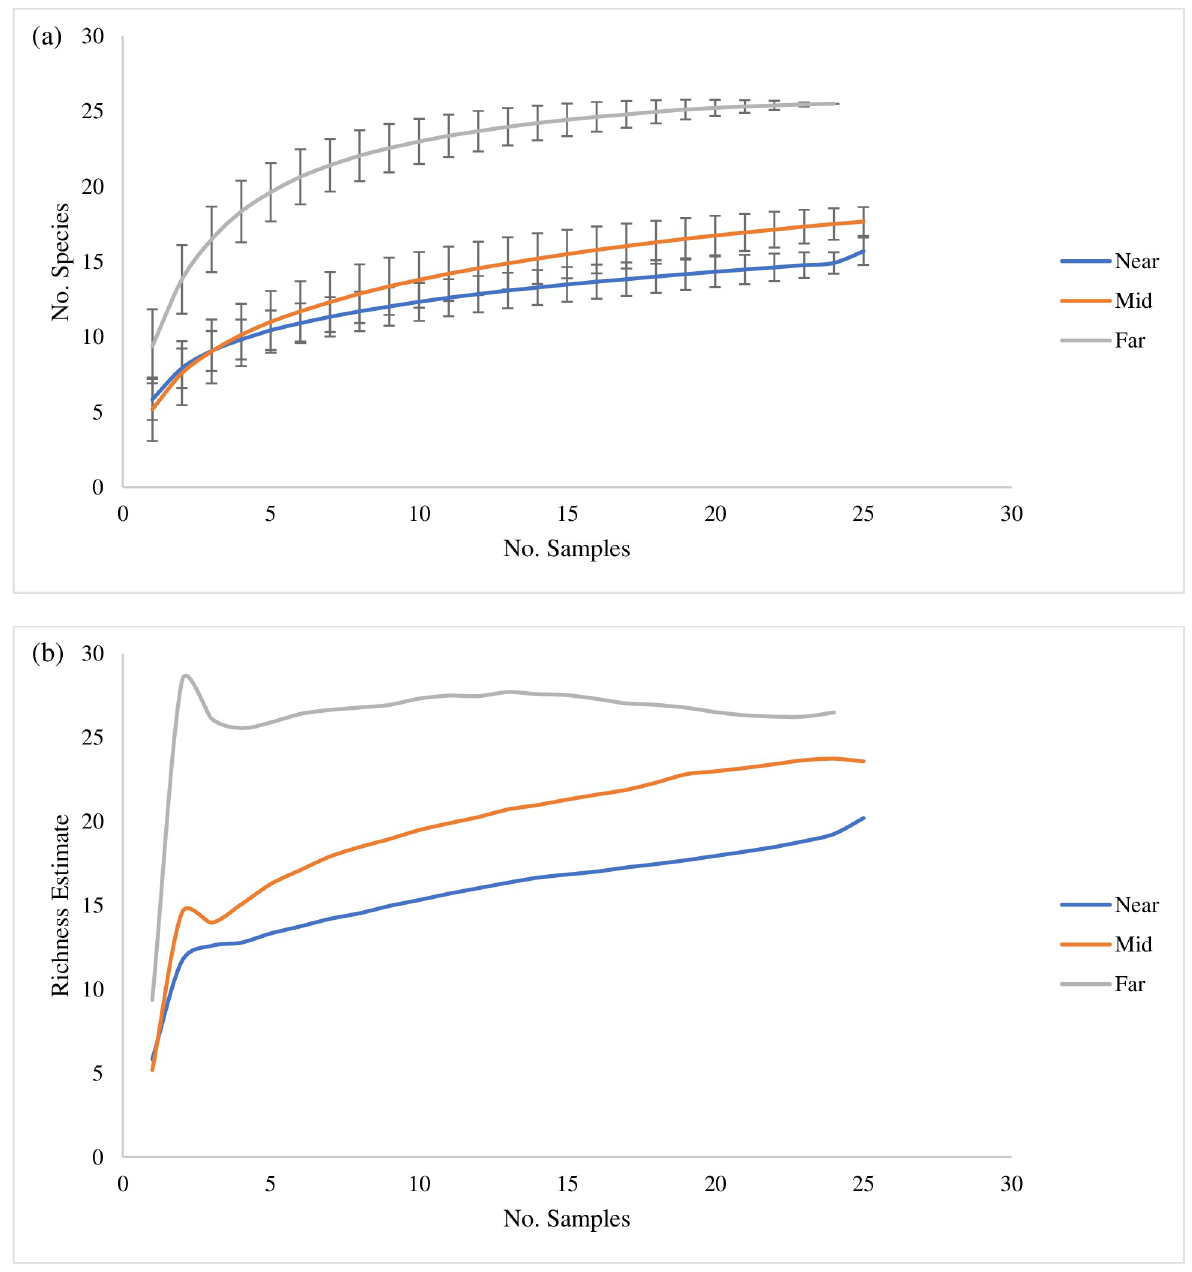
Fig 2. Species accumulations curves and richness estimates. (a) The species accumulation curve, S observed, shows the average observed species for each zone (near, mid and far) with standard deviation error bars present. (b) Average CHAO 1 richness estimator curves for each zone (near, mid and far). For species accumulation curves and CHAO 1 richness estimates of individual sites see Supporting